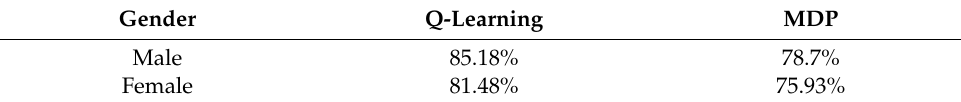
Table 9. Concordance rate of Q-learning and MDP between model’s recommendation and doctor’s prescriptions.